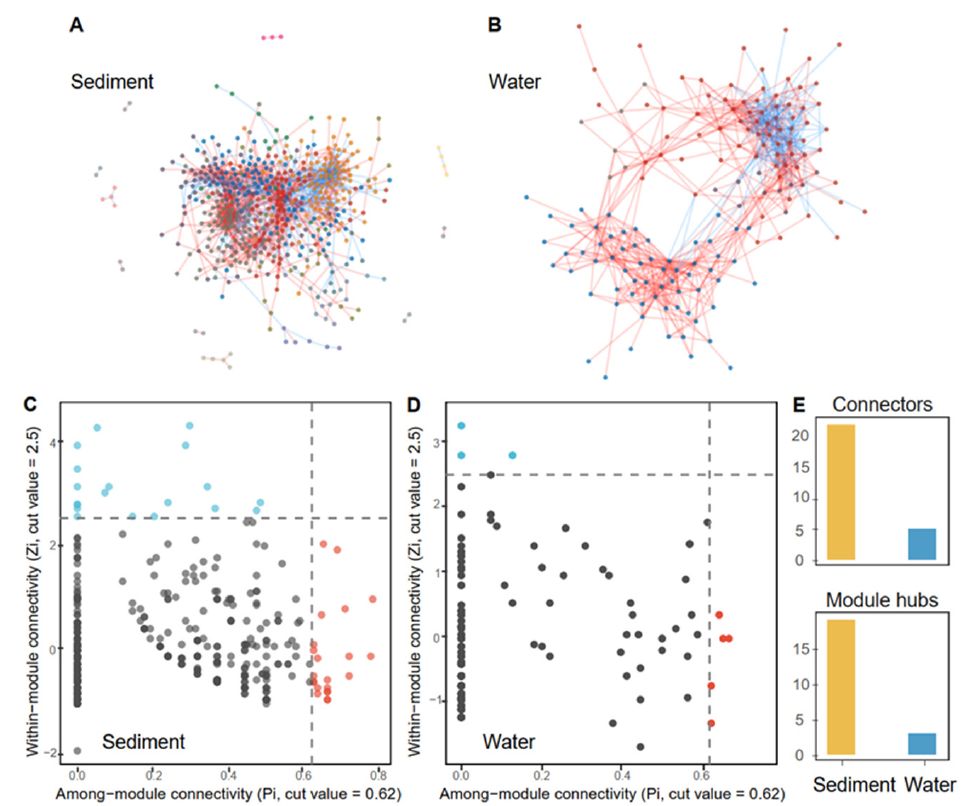
Figure 5. Salterns networks in sediment and water samples. ( A , B ), Visualization of the microbial MENs in sediment and water groups. Modules are randomly colored. The red and blue links between nodes represent positive and negative relationships, respectively. ( C , D ), The role of OTUs in network communities were determined by within-module connectivity ( Z i ) and among-module connectivity ( P i ). The light blue and red points represent module hubs and connectors, respectively. ( E ), Summary of keystone taxa (including module hubs and connectors).